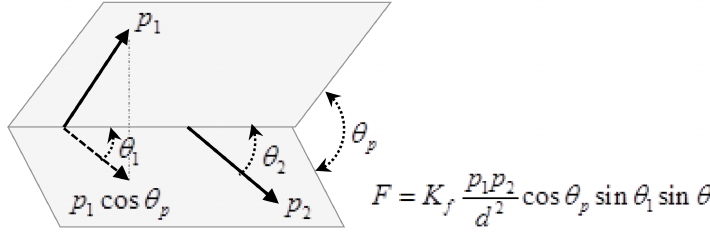
Fig. 1. Fundamental force working on